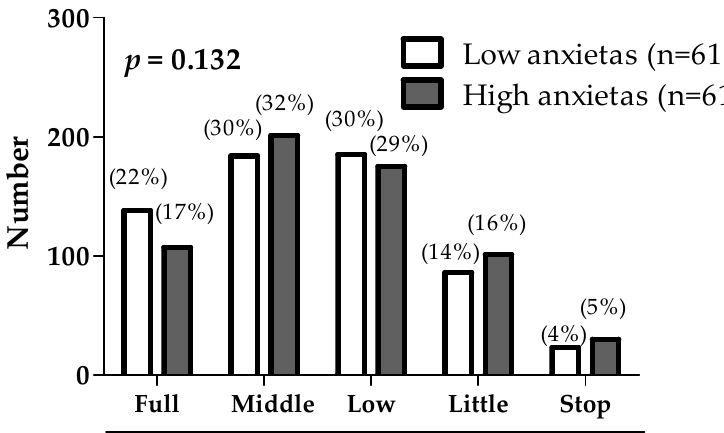
Figure 3. Relationship between anxietas (anxiety as a personality trait) of parents and the progress of home-based oral immunotherapy (OIT). Data are shown as the number of respondents and percentage (parents).